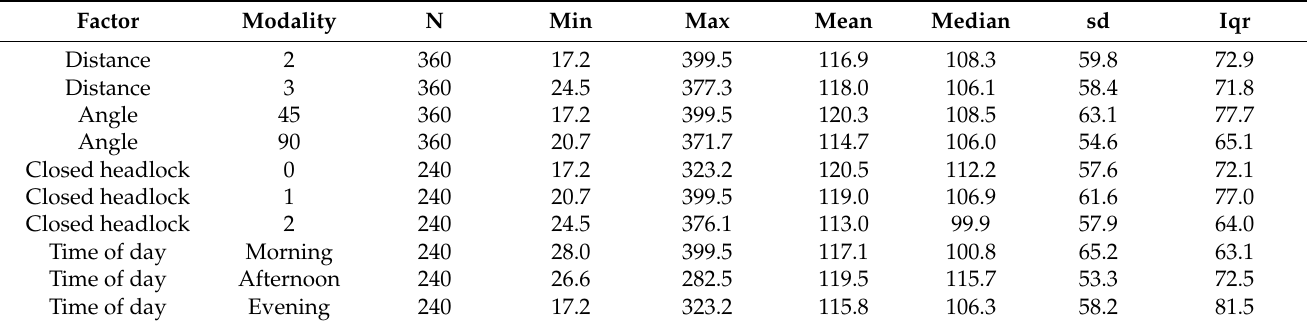
Table 3. Descriptive statistics of LMD data by factors and modalities. Statistical analysis of